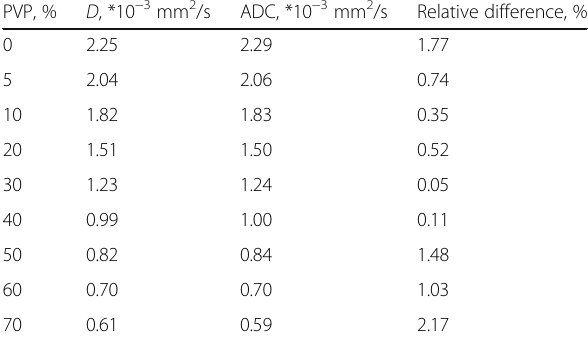
Table 1 Simulated data vs QA-DWI scan